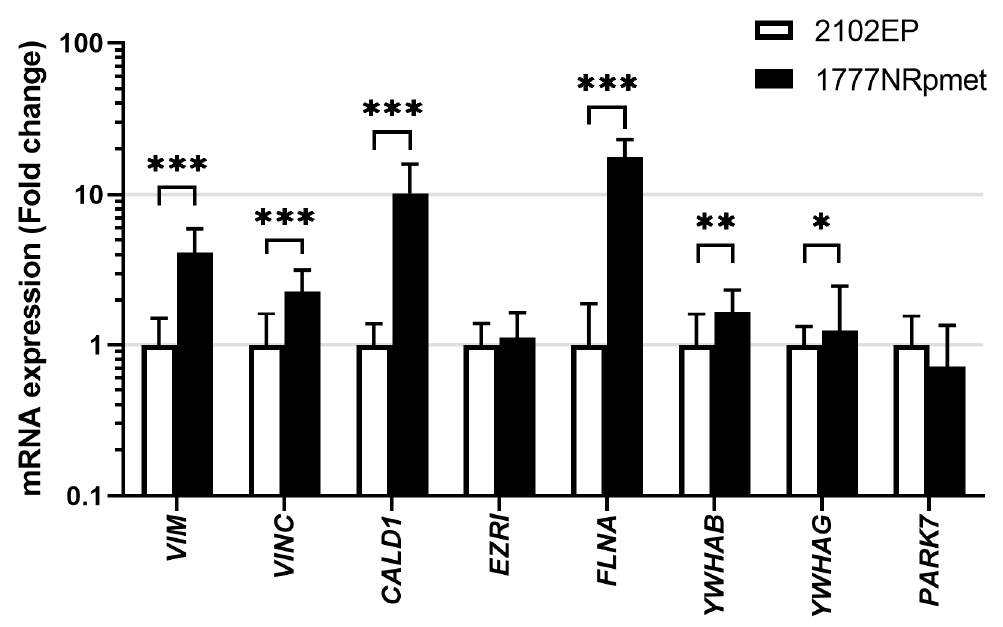
Figure 3. Expression of 14-3-3 β , 14-3-3 γ , caldesmon, ezrin, filamin A, PARK7, vimentin and vinculin at the mRNA level in primary tumour- and metastasis-derived TGCT cell lines. Expression of the 14-3-3 β , 14-3-3 γ , caldesmon, ezrin, filamin A, PARK7, vimentin and vinculin mRNAs in 2102EP and 1777NRpmet TGCT cell lines. Data are the means of three independent experiments. Error bars represent upper and lower limit of the expression. * p < 0.05; ** p < 0.01 and *** p < 0.001.